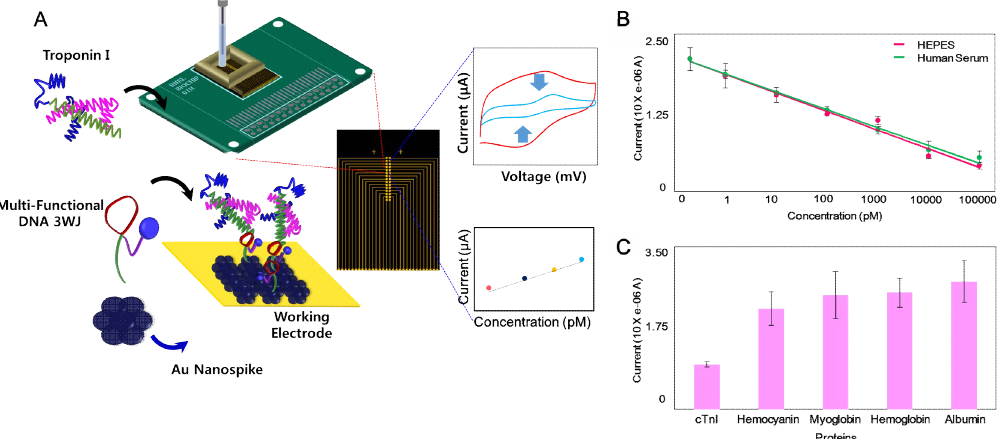
Figure 1. ( A ) Schematic diagram of the electrochemical (EC)-based troponin (TNI) biosensor consisted of DNA 3WJ/Au nanospike on Au micro-gap/PCB system, ( B ) reduction potential of the fabricated biosensor to various concentrations of TNI in HEPES (2-[4-(2-hydroxyethyl) piperazin-1-yl]ethanesulfonic acid) buffer and human serum (0 pM to 100 nM), ( C ) reduction potential of the fabricated biosensor to various target proteins in the HEPES buffer (TNI, Hemocyanin, Myoglobin, Hemoglobin, Albumin). (Reproduced with permission from the authors of reference [38], published by Elsevier, 2019).